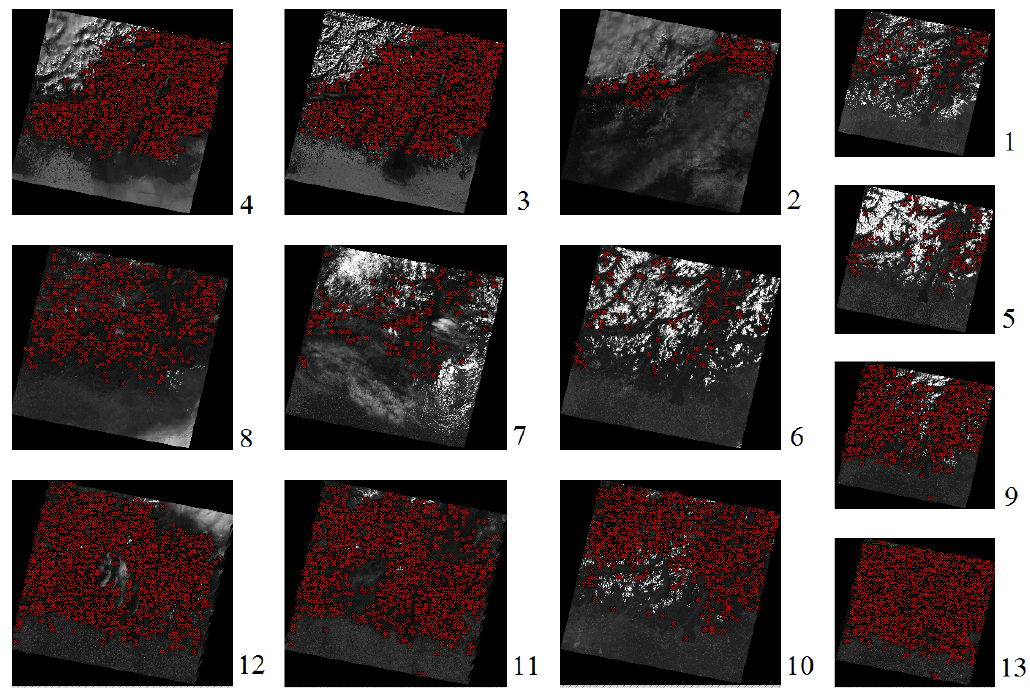
Figure 3. Automatically matched features for the whole time